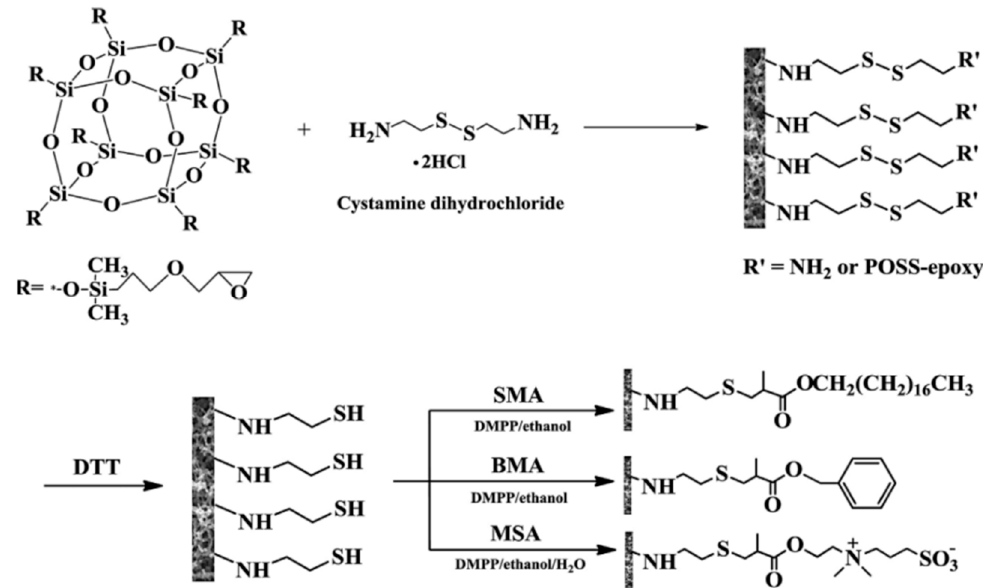
ring opening polymerization and post-functionalization based on thiol-ene click reaction. Taken